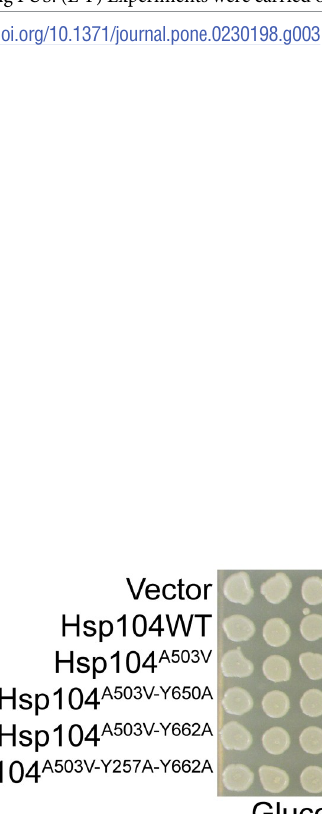
Fig 3. Ablation of Hsp104 Y650 subtly diminishes rescue of potentiated Hsp104 A503V . (A) W303 Δ hsp104 yeast integrated with the gene encoding TDP-43 were transformed with the indicated 416GAL-Hsp104 plasmid or empty vector control. Strains were serially diluted 5-fold and spotted on glucose (off) or galactose (on) media. Scores are based on number of spots (from 1 to 6), based on an average of three biological replicates. (B) Strains from A were induced for 5h, lysed, and immunoblotted. 3-Phosphoglycerate kinase (PGK) serves as a loading control. (C-D) Experiments were carried out as in A, except with a strain integrated with the gene encoding FUS. (E-F) Experiments were carried out as in A, except with a strain doubly integrated with the gene encoding α -synuclein-YFP.